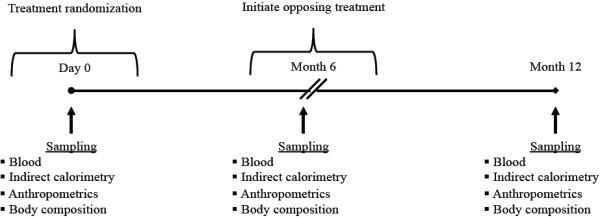
Experimental design followed to examine metabolic response to consumption of low versus high dairy foods.